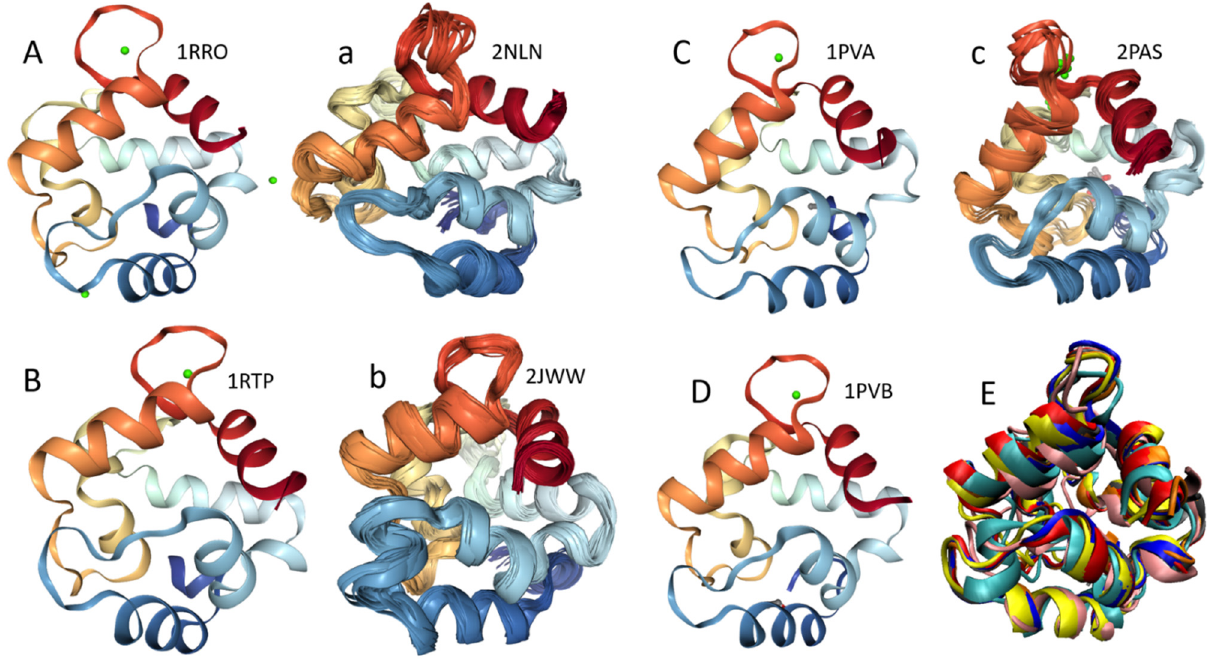
Figure 4. Comparison of 3D structures of various PAs. ( A ) X-ray crystal structure of the holo-form of rat OM. ( a ) Solution NMR structure of the apo-form of rat OM. ( B ) X-ray crystal structure of the holo-form of rat α -PA. ( b ) Solution NMR structure of the apo-form of rat α -PA. ( C ) X-ray crystal structure of the holo-form of pike α -PA. ( c ) Solution NMR structure of the holo-form of pike α -PA. ( D ) X-ray crystal structure of the holo-form of pike β -PA. ( E ) Multiple structural alignment of all these proteins in their holo- and apo-forms. Structures of the holo- and apo-forms of rat OM are shown by blue and cyan colors. Red and pink colors represent structures of the the holo- and apo- forms of rat α -PA. Crystal and solution structures of pike α -PA are shown by orange and yellow color, whereas crystal structure of the holo-form of pike β -PA is shown in gray. Multiple structural alignment was conducted using MultiProt server (http://bioinfo3d.cs.tau.ac.il/MultiProt/; Accessed on 23 April, 2022).